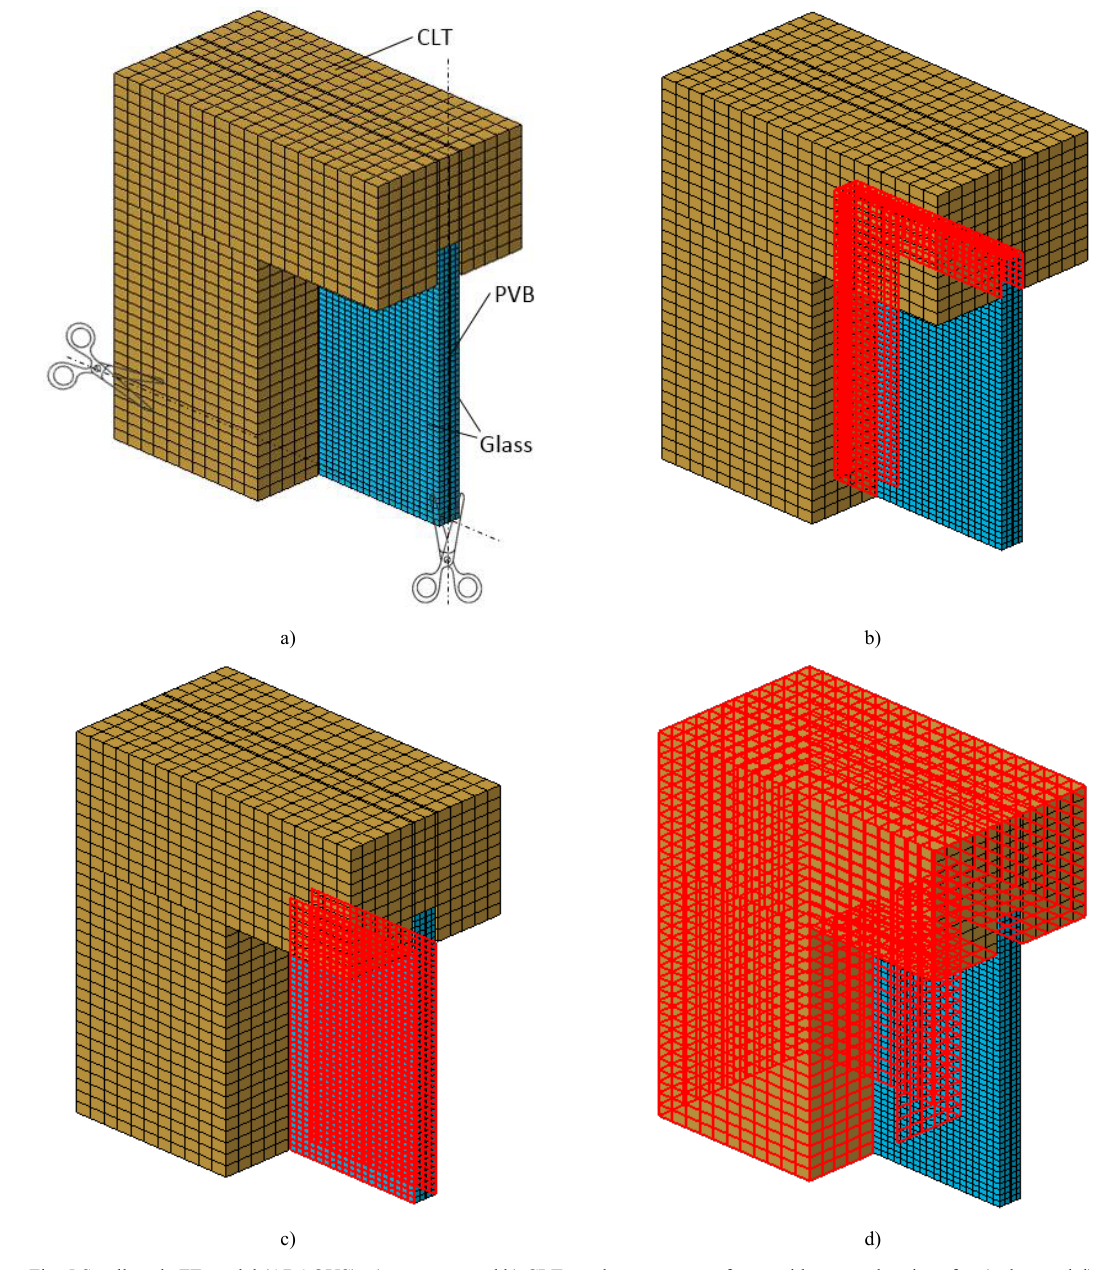
Fig. 5 Small-scale FE model (ABAQUS): a) geometry and b) CLT-to-glass contact surfaces, with exposed regions for c) glass and d)